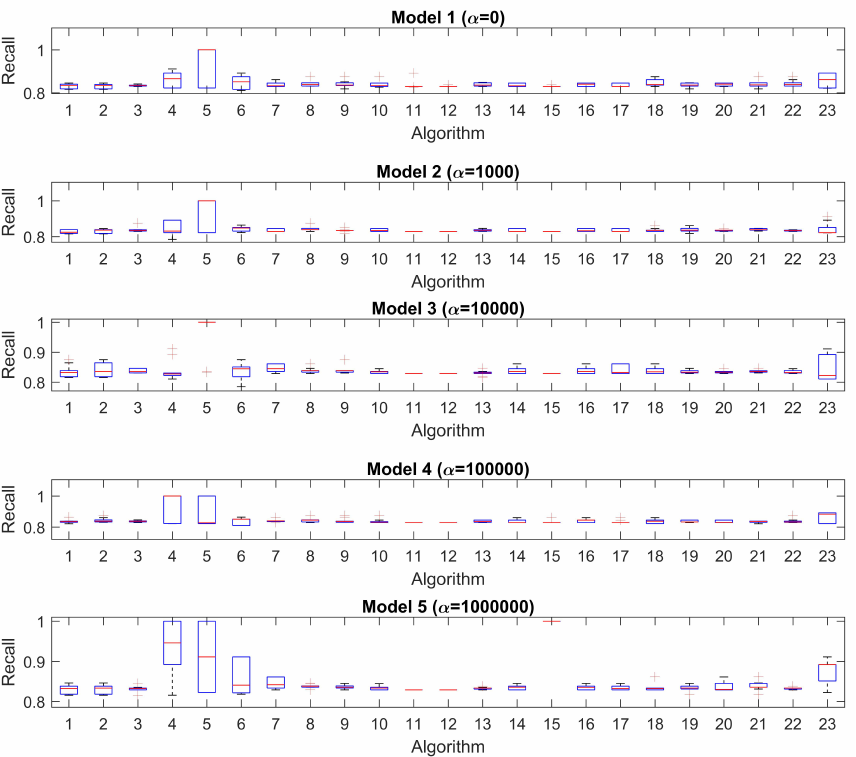
Figure A8. Numerical simulation assumption 3 (Constant). Recall of various models after permuta- tions in the numerical values of the mapping. The 23 algorithms are represented in the x -axis, and the accuracy is shown in the y